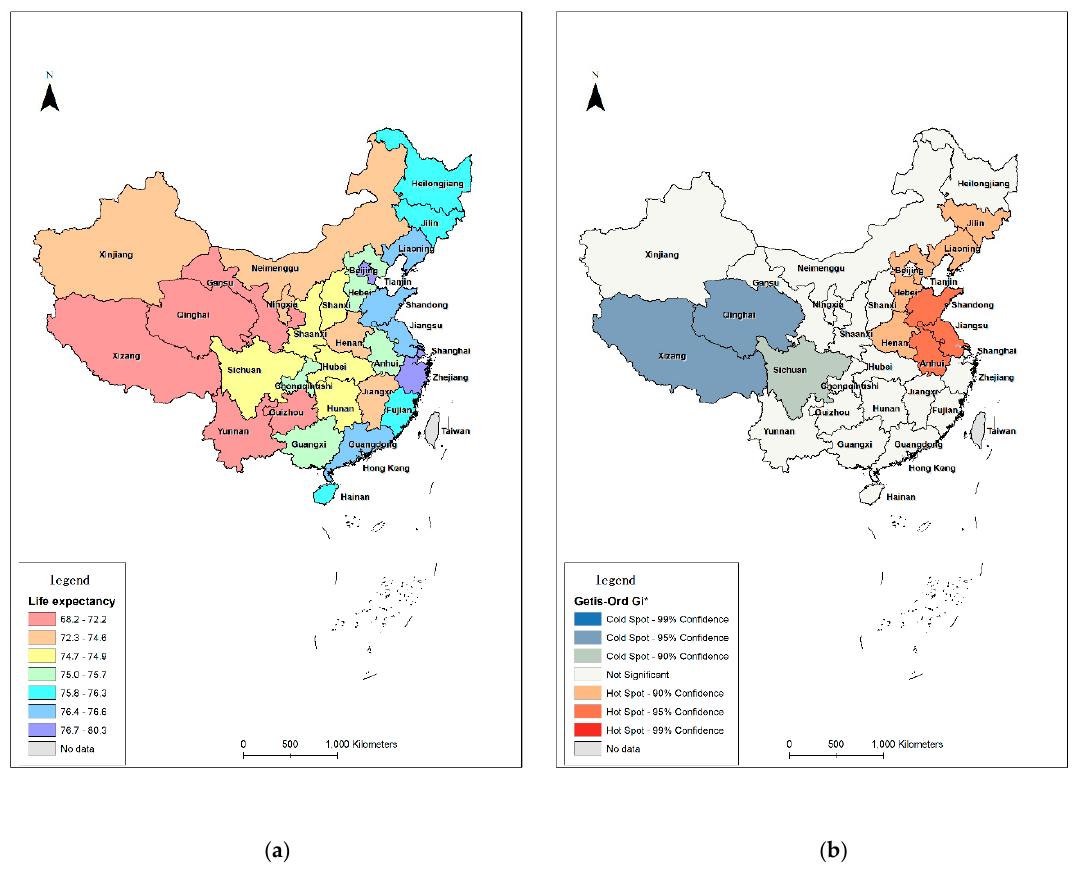
Figure 2. Spatial distribution and clustering of Life expectancy of older people in China ( a ) life expectancy of older people in China, and ( b ) Getis-Ord Gi* of older peple in China.